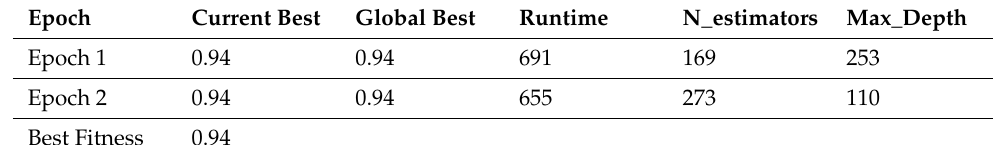
Table 14. RF hyperparameters optimization using